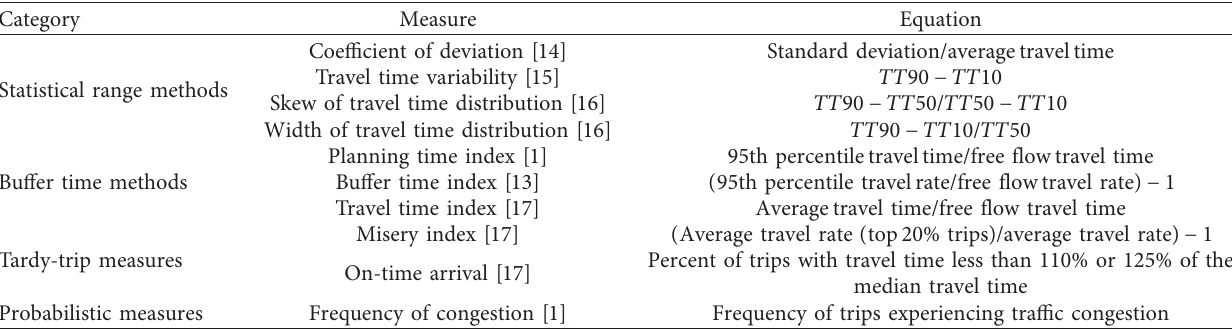
Table 1: Summary of widely used TTR